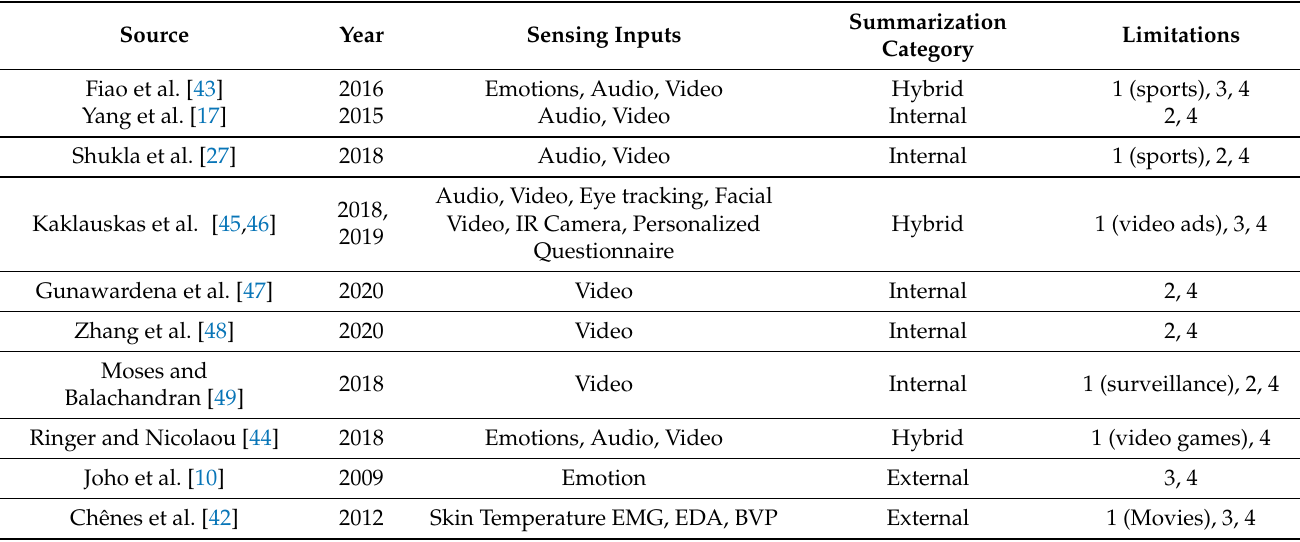
Table 2. Limitations of existing studies in highlight